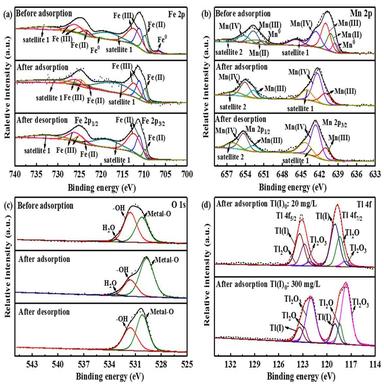
XPS spectra of nZVIM adsorbent before and after adsorption and desorption: (a) Fe 2p; (b) Mn 2p; (c) O 1s; (d) Tl 4f.